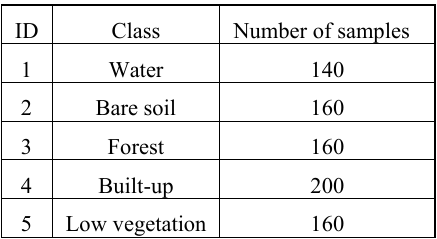
Table 5. Error matrix for the XGB classification